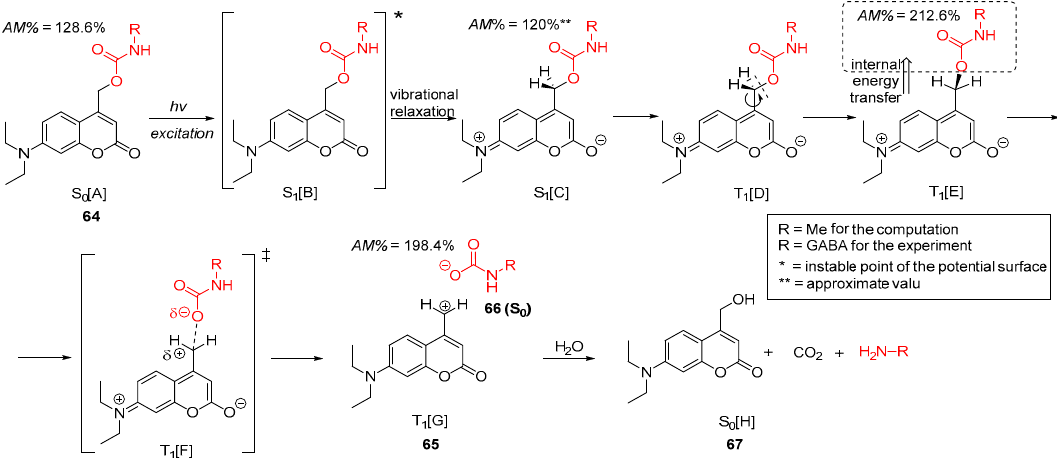
Figure 27. Mechanism of the photochemical initiated scission of coumarin-caged model compound 64 to products 66 + 67 by an internal energy transfer, computed at B3LYP/6-31G(d,p)//PCM(water) level of theory. The amidicity values (AM%) are also shown for some structures.